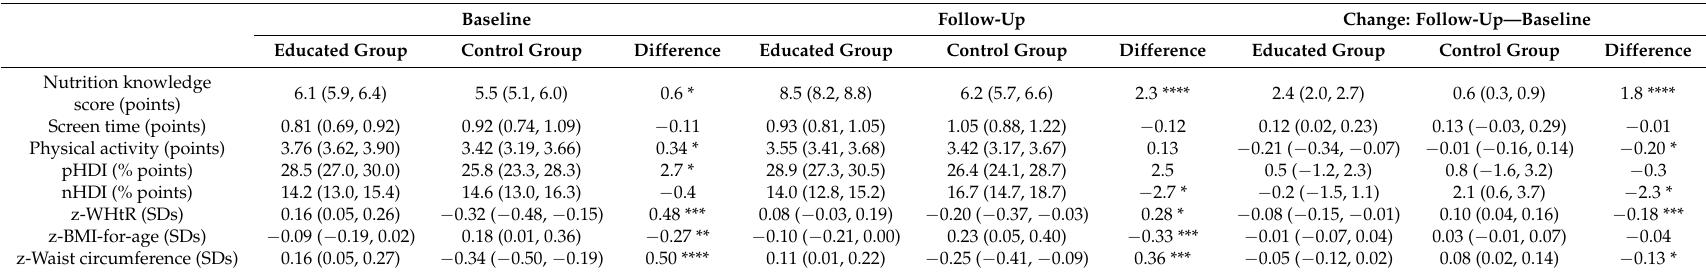
Table 4. Means and mean changes (95% CI) in nutrition knowledge, sedentary and active lifestyle, diet quality and body composition in educated and control groups at a nine-month